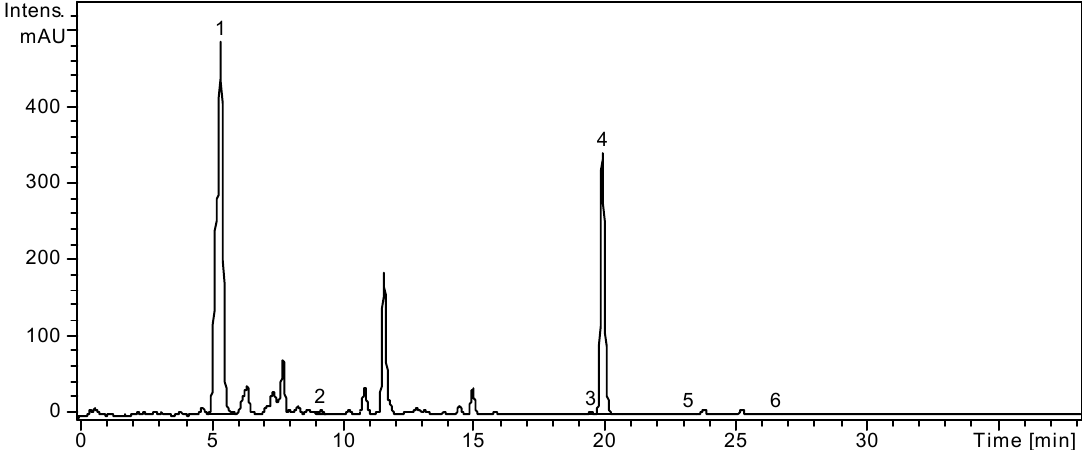
Figure 1. HPLC chromatogram of L. barbarum sample.